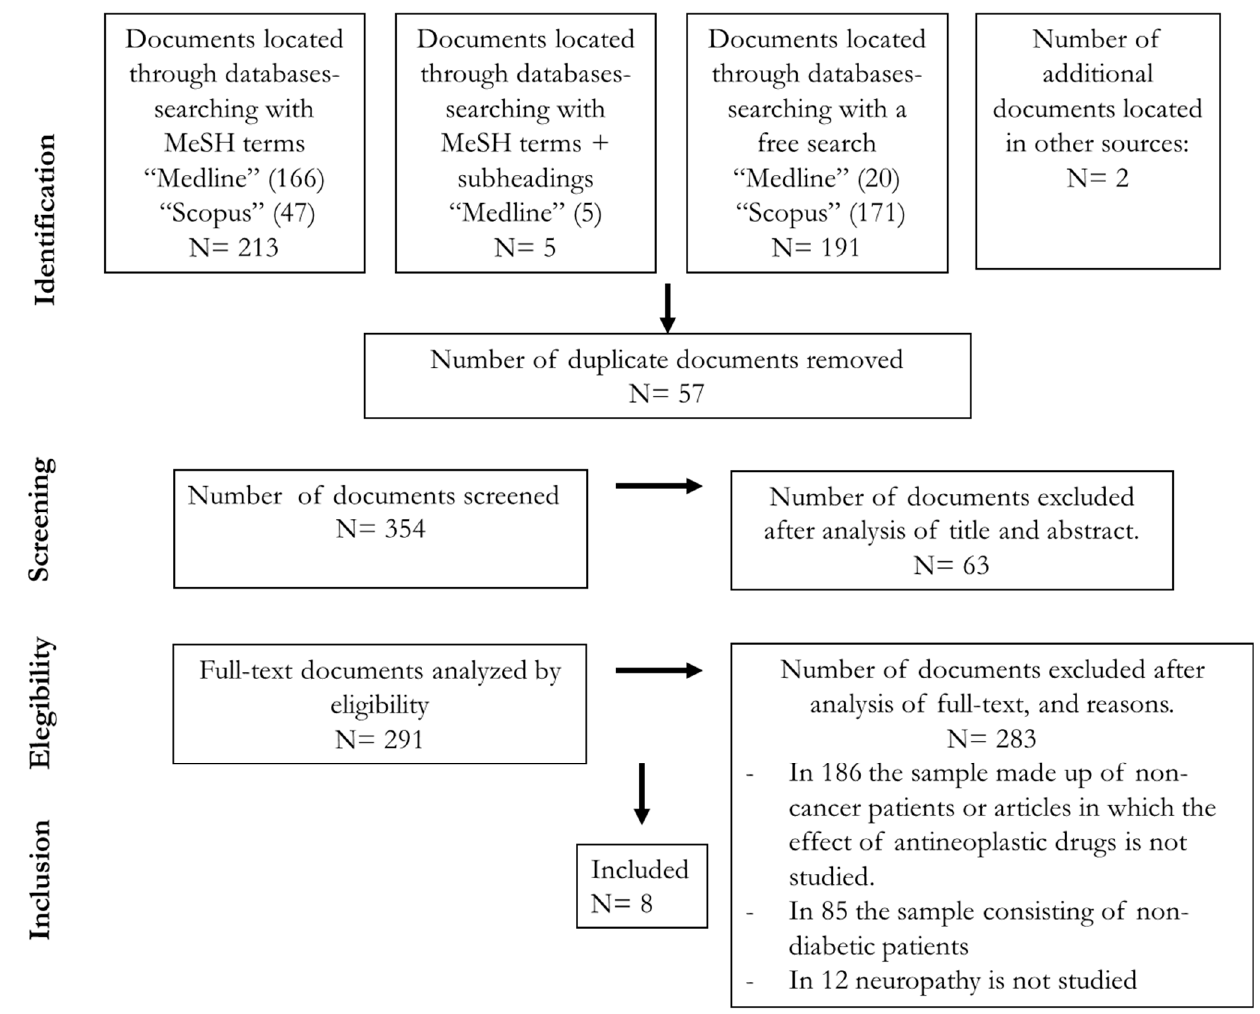
Figure 1. Systematic review workflow.